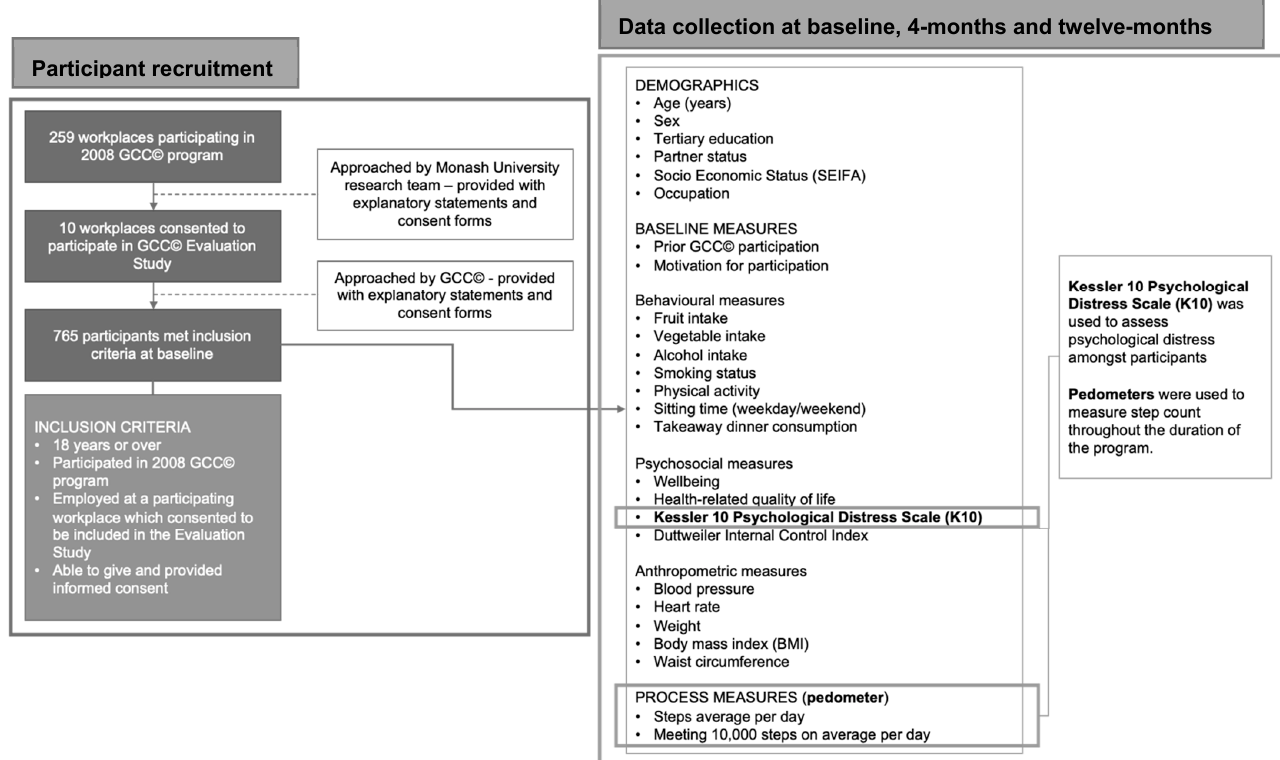
Figure A1. Participant recruitment and data collection at baseline, 4-months and 12-months for the GCC© Evaluation Study. Process measures were only collected at 4-months.